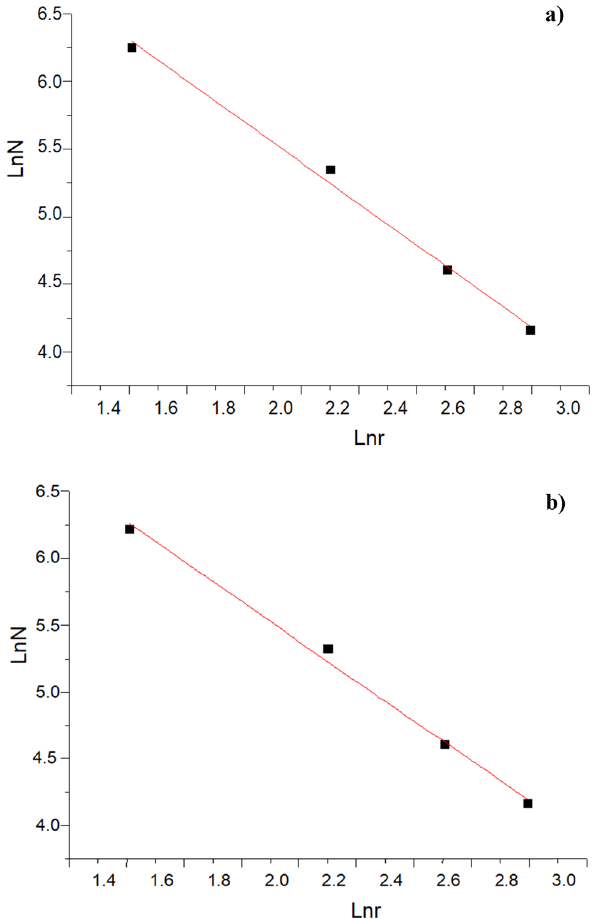
Figure 12: Grid coverage of aggregate in particle group state boundary line.